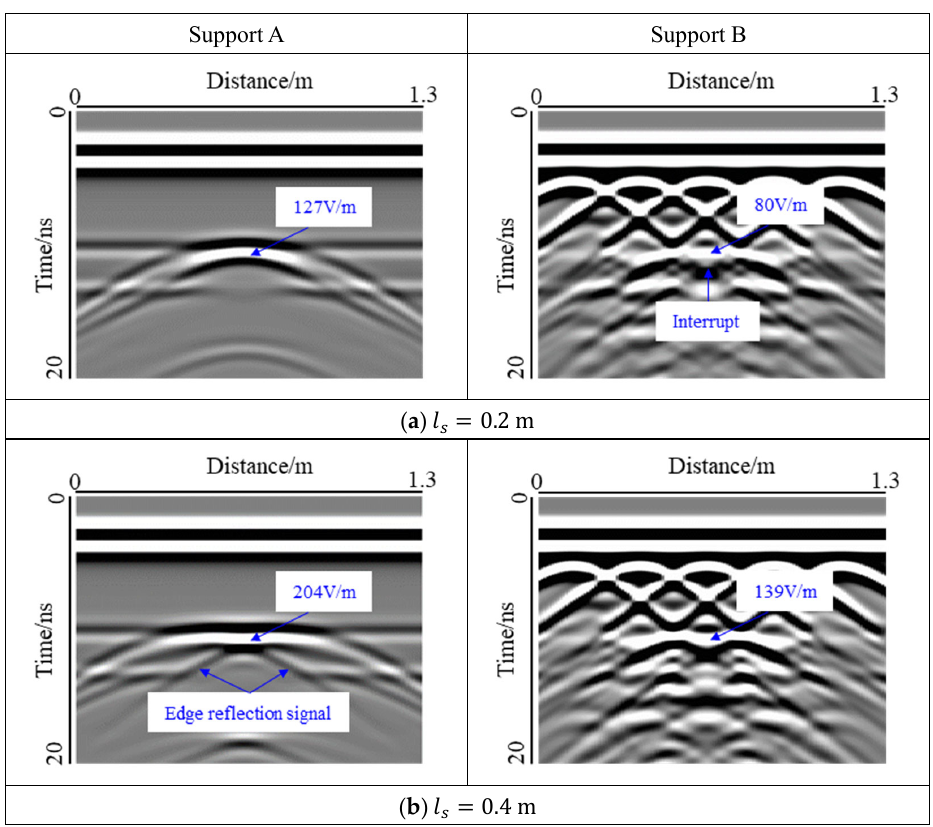
Figure 8. Forward image of support B. The steel bars caused the strong reflection and diffraction of electromagnetic waves, which covered the reflected signals from interface Ⅰ and Ⅱ .